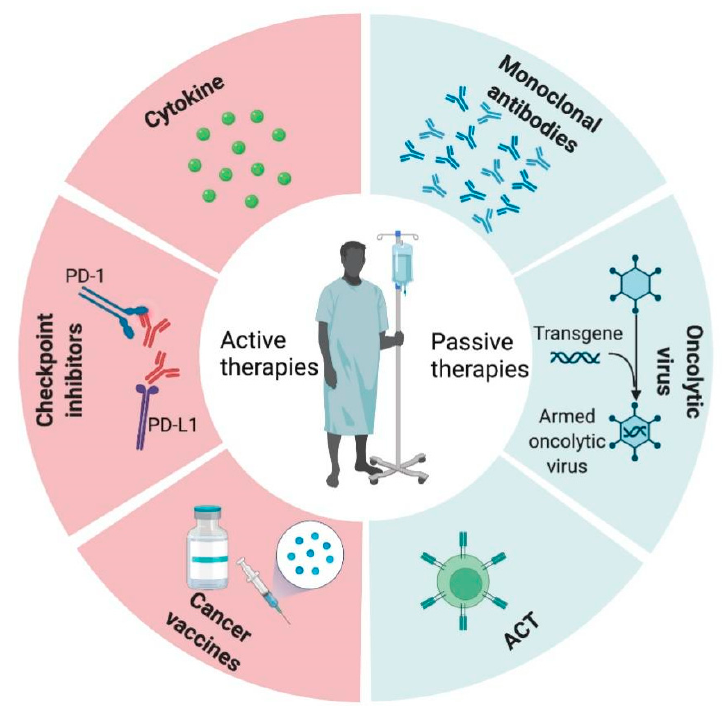
Figure 2. Classification of tumor immunotherapy . Immunotherapy is categorized as either ‘active’ (checkpoint inhibitors, cytokine and cancer vaccines) or ‘passive’ (monoclonal antibodies, oncolytic viruses and ACT).